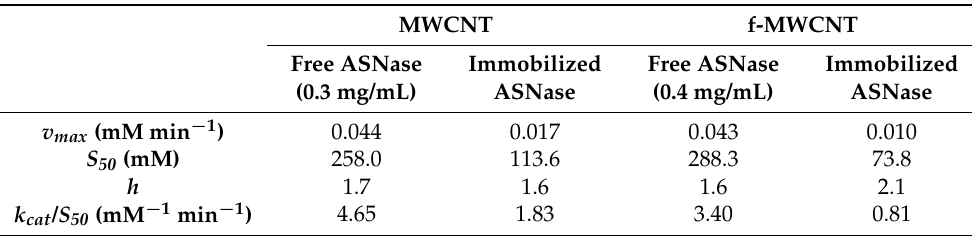
Table 4. Kinetic parameters for free and immobilized L-asparaginase (ASNase) onto pristine and functionalized multi-walled carbon nanotubes (f-MWCNTs). MWCNT f-MWCNT Free ASNase Immobilized Free ASNase Immobilized (0.3 mg/mL) ASNase (0.4 mg/mL) ASNase v max (mM min − 1 ) 0.044 0.017 0.043 0.010 S 50 (mM) 258.0 113.6 288.3